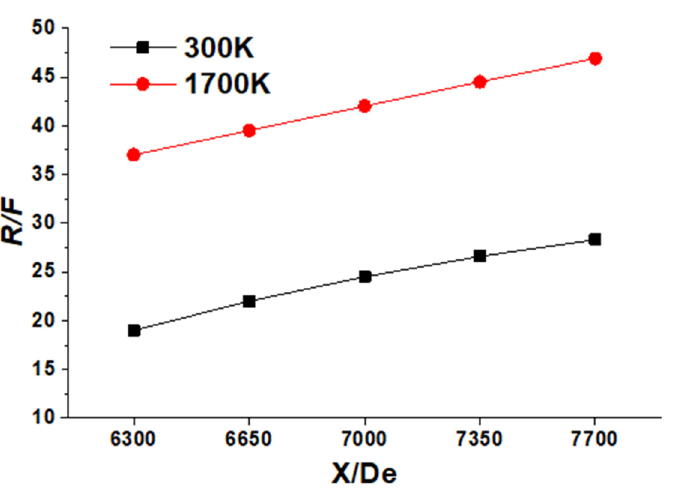
Figure 8. The R/F distribution with a lance height of 1550 mm at the Laval nozzle centerline. The results show that the ratio of R/F improves with the total flow rate and ambient temperature. The R/F at a high ambient temperature for the total flow rate of 6300, 6650, 7000, 7350, and 7700 Nm 3 /h are, respectively, 1.95, 1.80, 1.71, 1.67, and 1.66 times larger than that at the room ambient temperature. Therefore, the R/F increases with the ambi- ent temperature, but a greater total flow rate will suppress this increasing rate of the R/F .